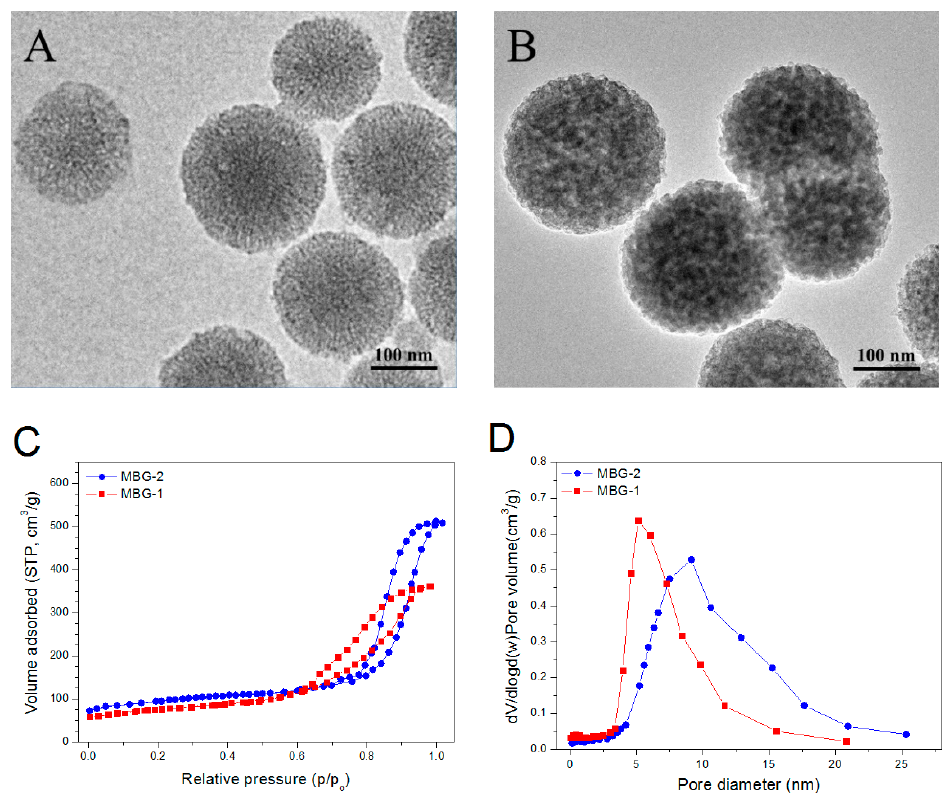
Figure 2. Images of MBG-1 ( A ) and MBG-2 ( B ) nanoparticles (NPs); N 2 adsorption isotherms ( C ) and pore size distribution ( D ) of NPs.